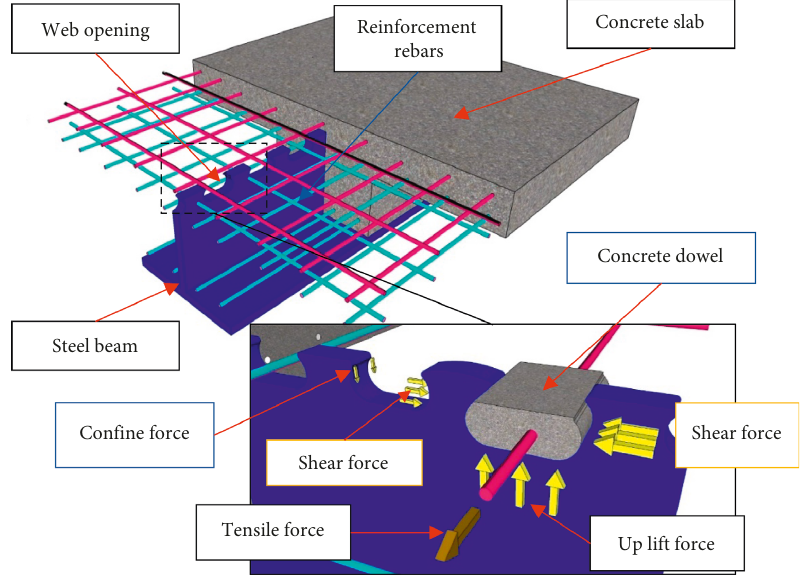
Figure 17: Composite dowels in steel beam system without the upper flange.